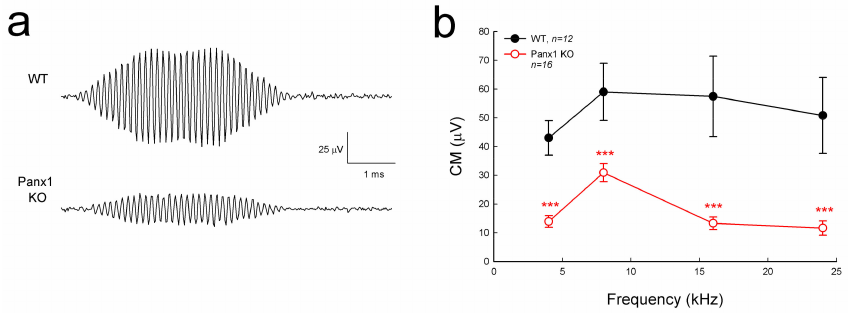
Figure 4. Cochlear microphonics (CM) reduction in the Gen-Panx1 KO mouse. ( a ): CM waveforms recorded from Gen-Panx1 KO and WT mice. ( b ): Reduction of CM in the Panx1 KO mouse. *** p < 0.001 as determined by one-way ANOVA with a Bonferroni